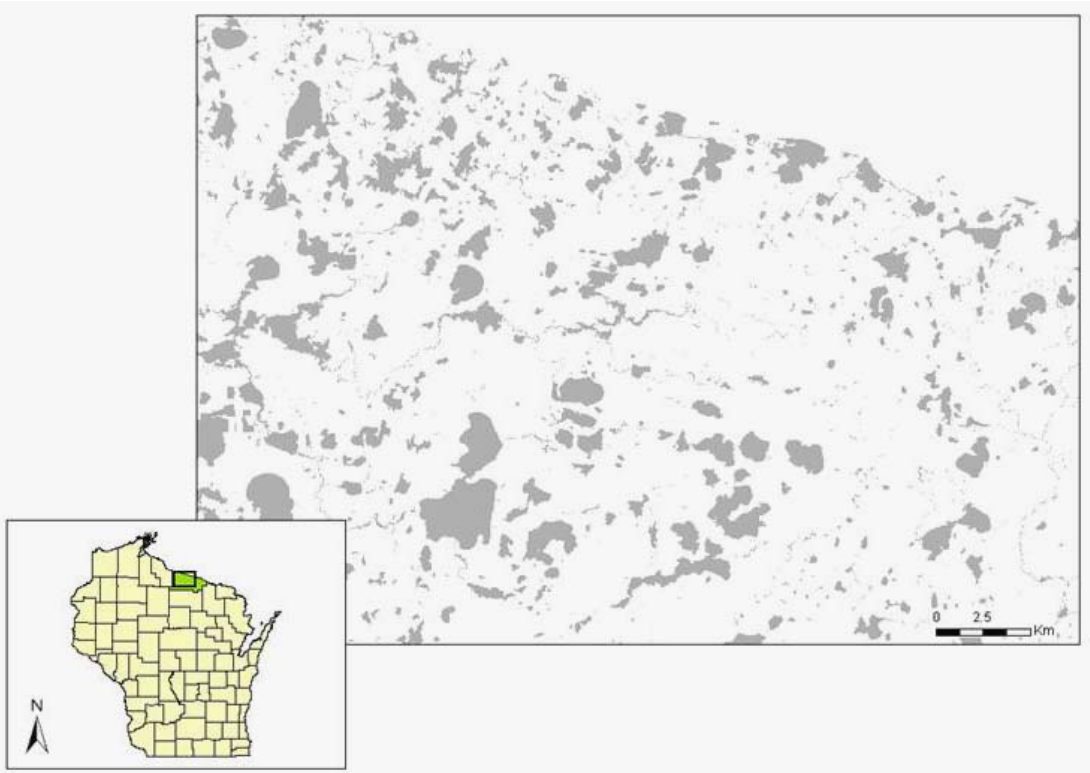
Figure 2. Study area in Vilas County, Wisconsin, USA. The grey areas show